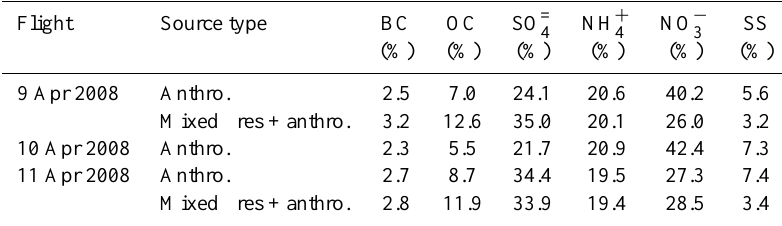
Table 2. Modeled PM 2 . 5 aerosol composition by source type along POLARCAT-France spring flights. BC, OC, and SS are black carbon, organic carbon, and sea salt,